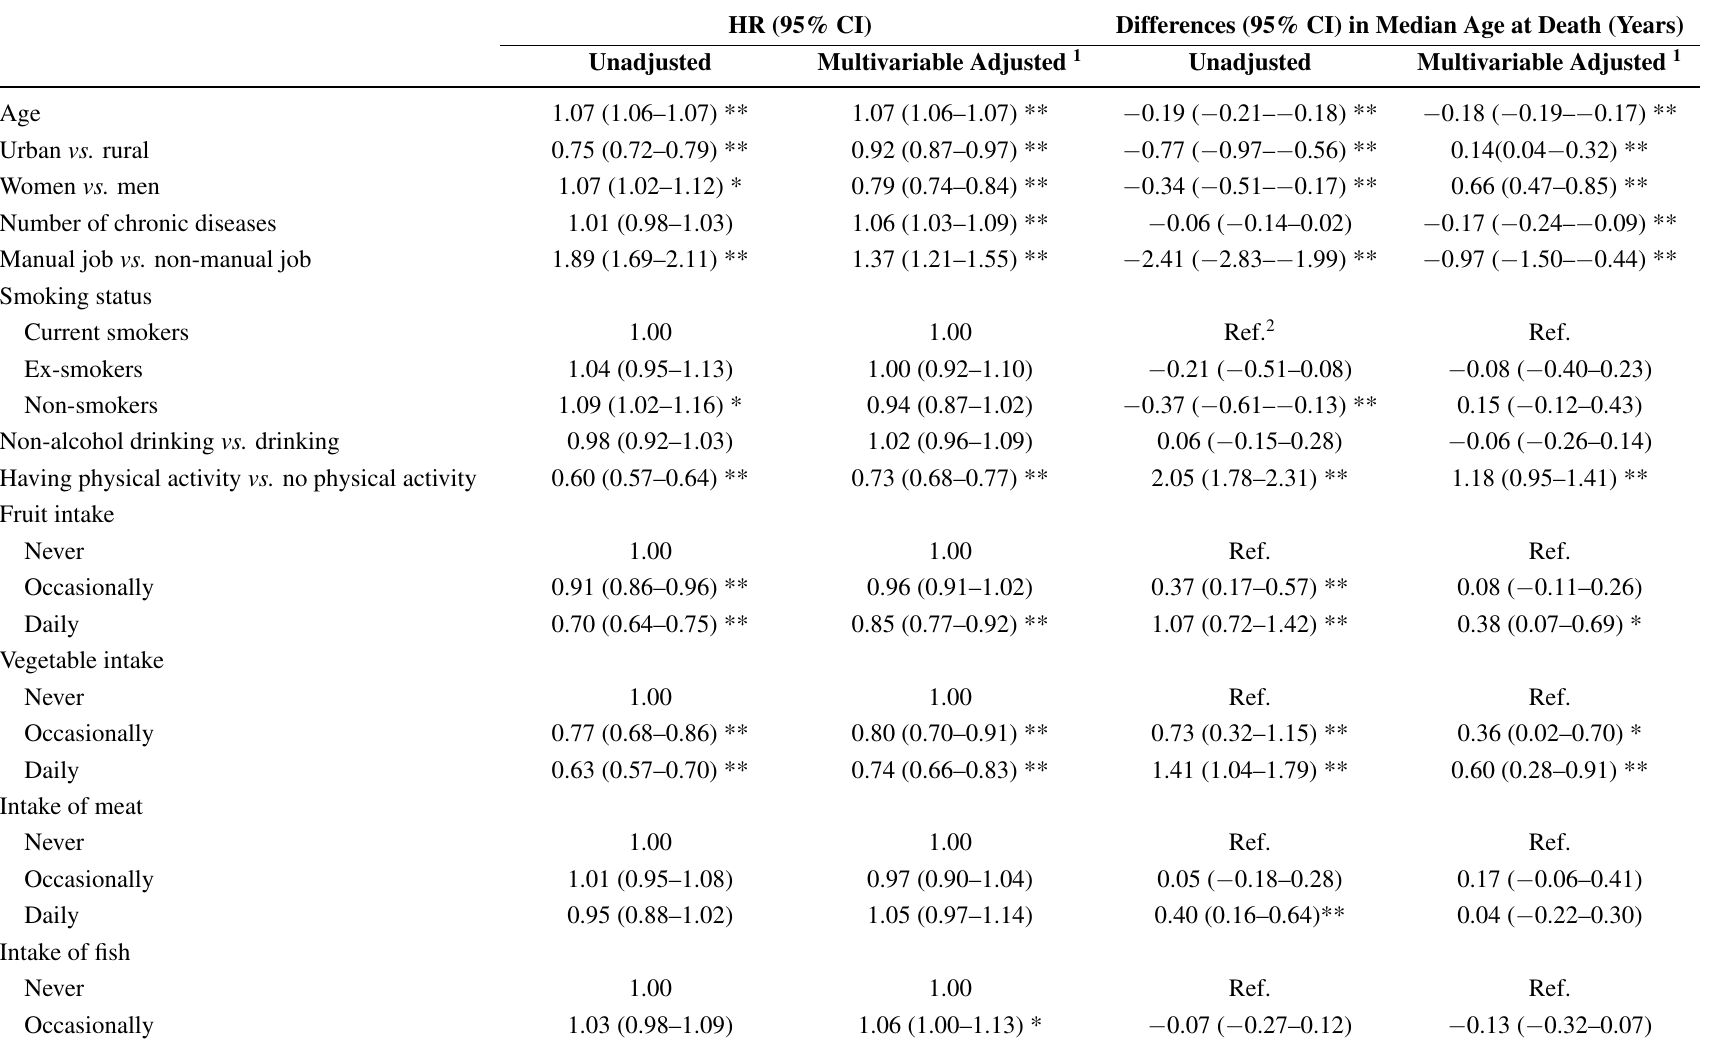
Table 3. Hazard ratios and differences in median age at death (95% CI) for all-cause mortality according to food frequency intake and other lifestyle factors among Chinese